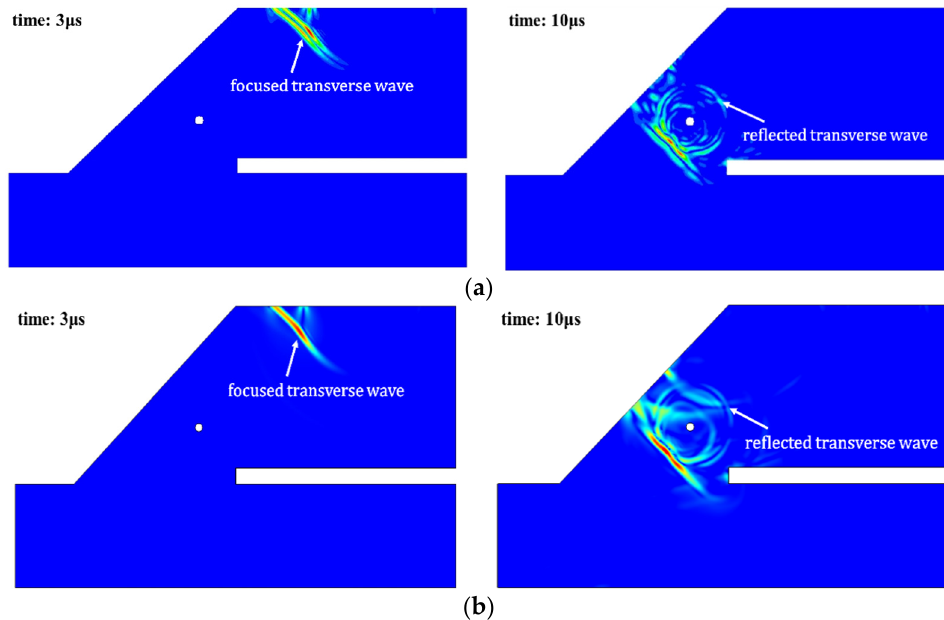
Figure 6. Simulated PA transverse wave focusing fields with a focusing angle of 56 ◦ and focusing depth of 27 mm using ( a ) the fast FEM code and ( b ) commercial finite element software.